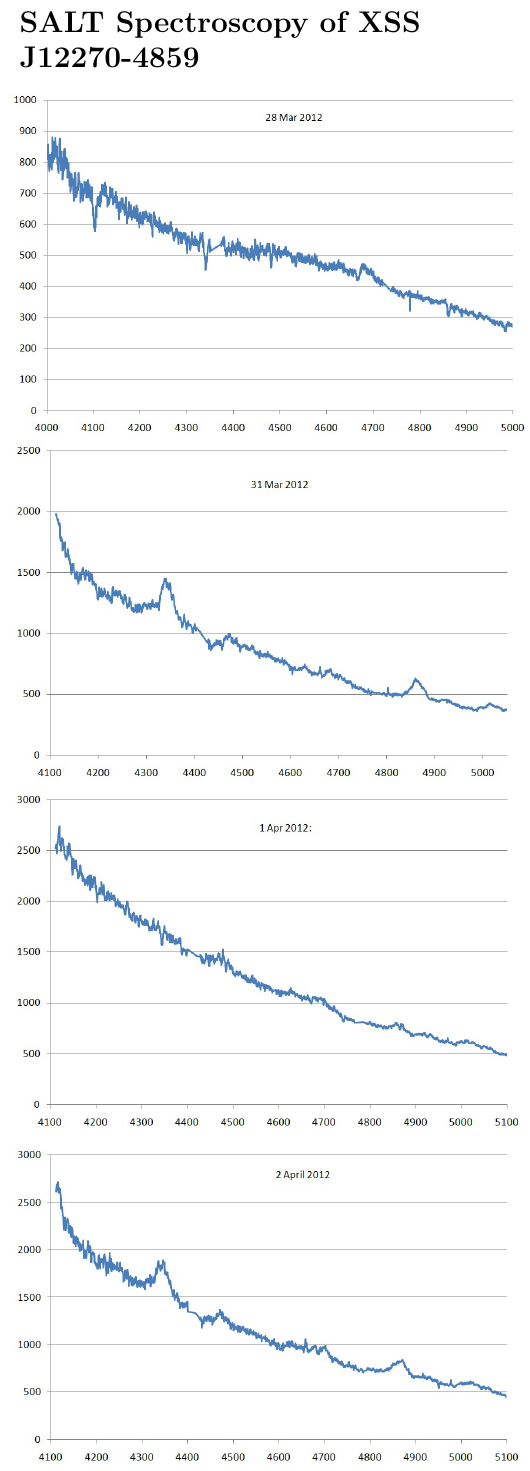
Figure 8: SALT spectra of XSS J12270-4859, averaged over ∼ 1 h on 4 different nights. The enigmatic FERMI gamma ray source, XSS J12270- 4859 (e.g. Bonnet-Bidaud et